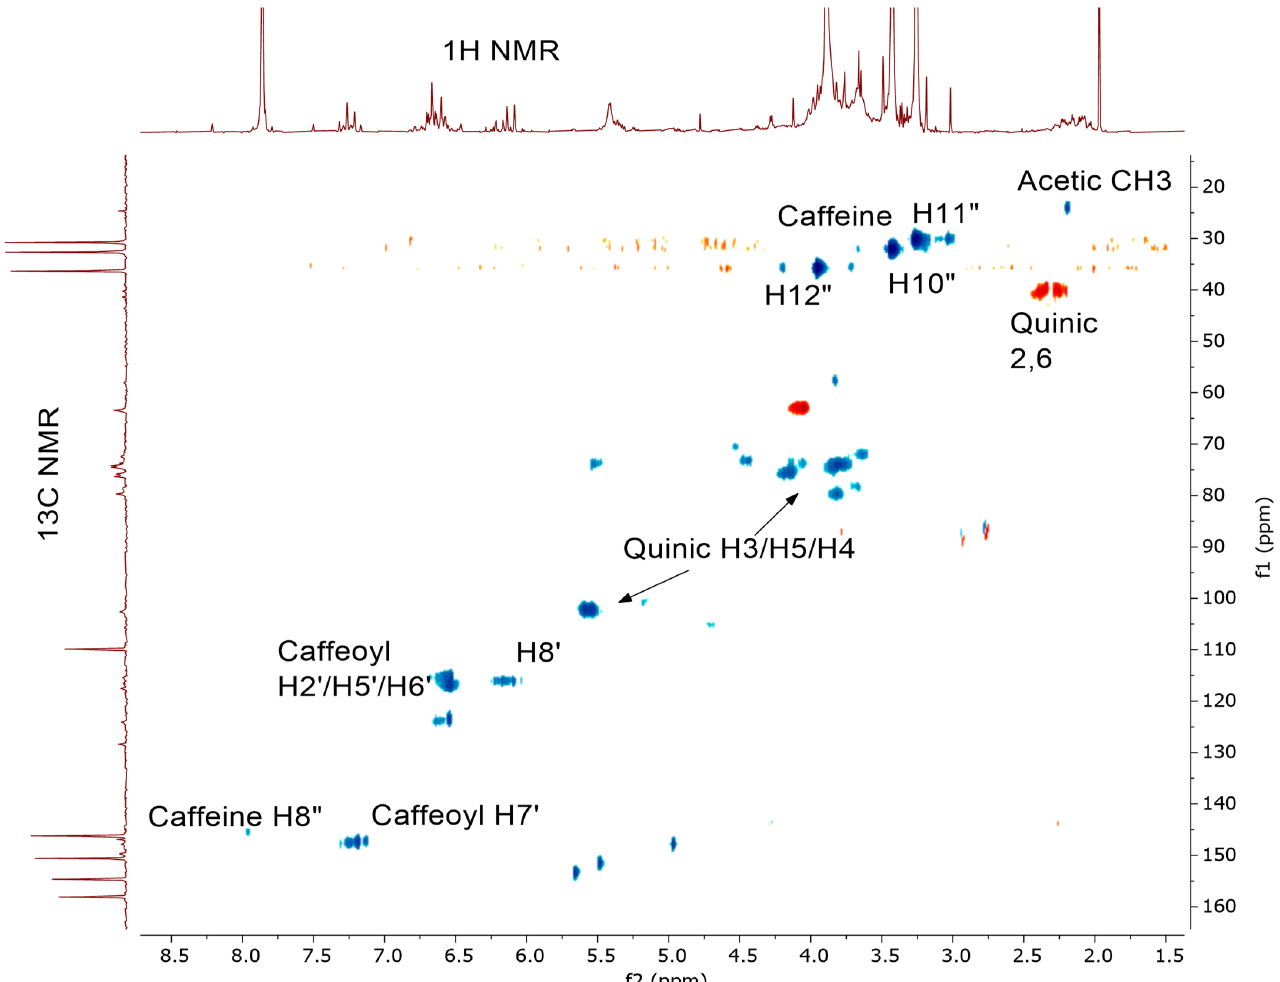
Figure 11. 1 H- 13 C gHSQC 2D-spectrum of CEWCCE in D 2 O.